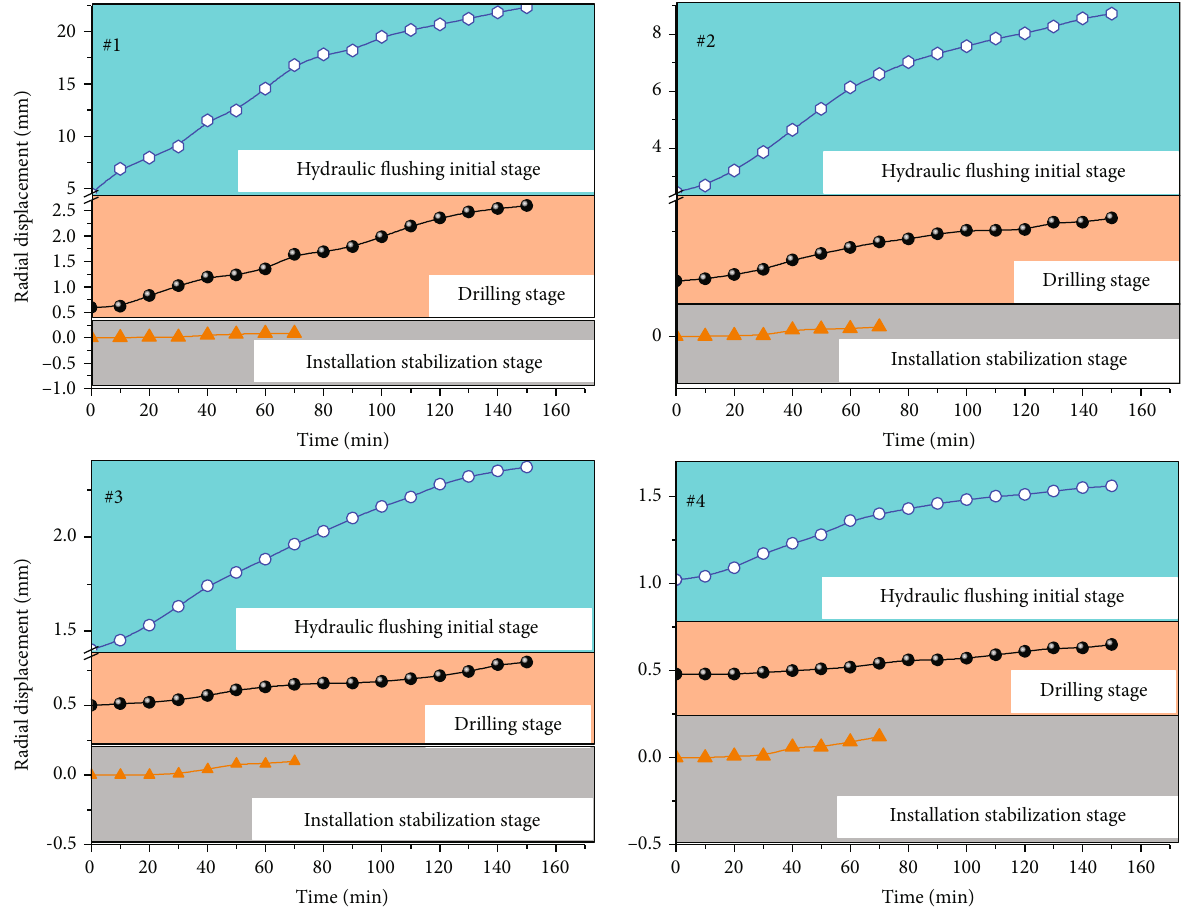
Figure 10: Radial displacement within various